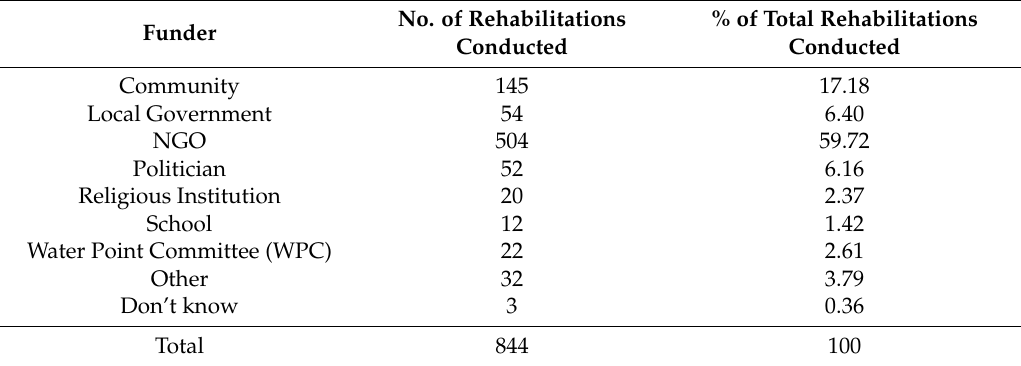
Table 2. Frequency of actors funding